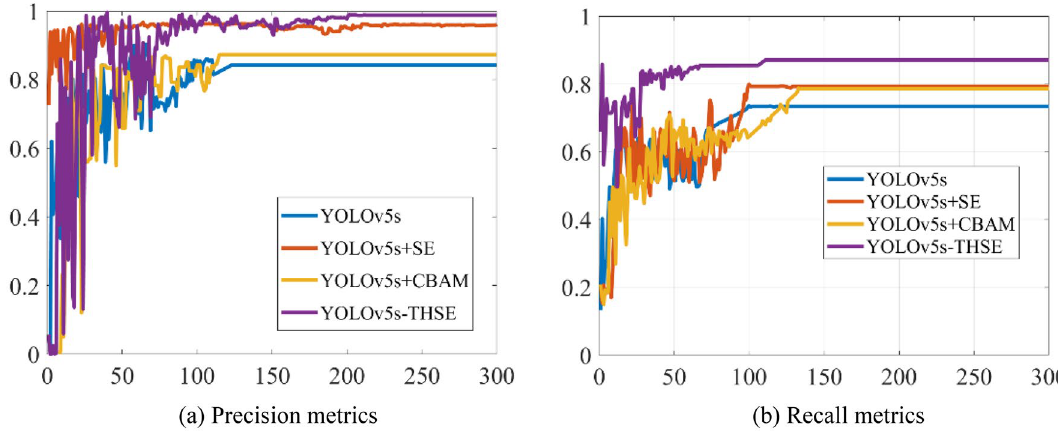
Figure 9. Comparison of precision and recall index of different models.